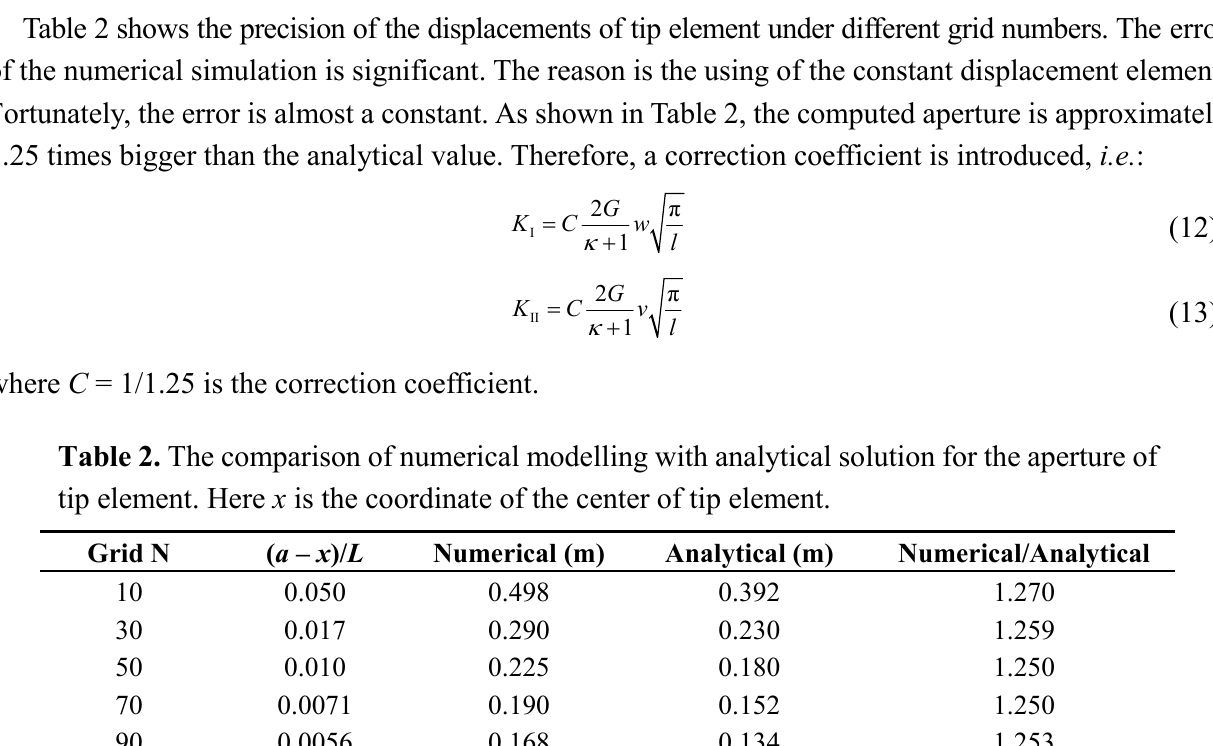
Figure 5. The comparison of numerical modelling with analytical solution.